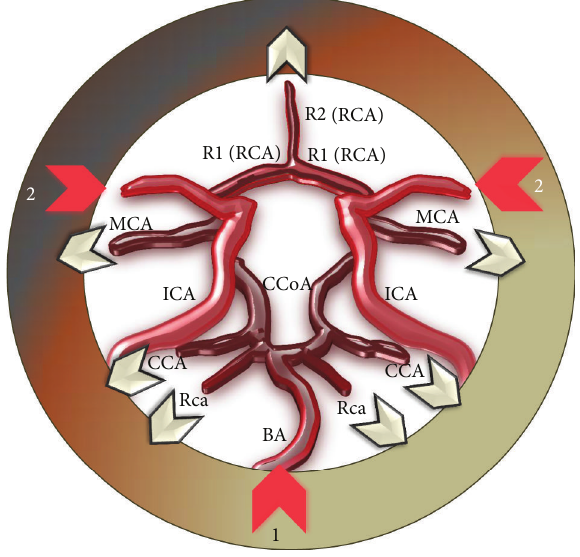
Figure 5: The drawing shows the blood flow to the Circle of Willis from the three vessels: 1, basilar artery (BA), and 2, internal carotid arteries (ICAs). From internal carotid arteries, blood flows from circle of Willis to the brain through the rostral cerebral arteries (RCA). The anterior communicating artery that connects the two anterior cerebral arteries in humans is rarely described in dogs. However, either the canine rostral cerebral artery can be subdivided into a pre-joining point (R1) and, generally, in a single median R2 segment (post-joining). Internal carotid artery gives off the median cerebral arteries (MCAs) and the caudal communicating arteries (CCoAs), that connect the circle with the basilar artery. In most dogs, the caudal cerebral artery (CCA) and the rostral cerebellar artery (RcAs) are from the caudal communicating